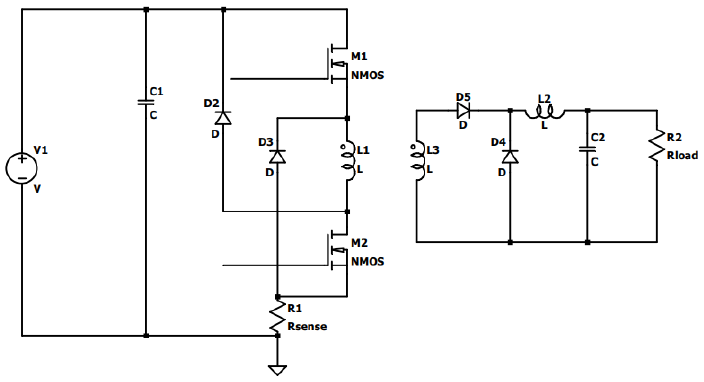
Figure 4. Topology of the two-switch forward converter.